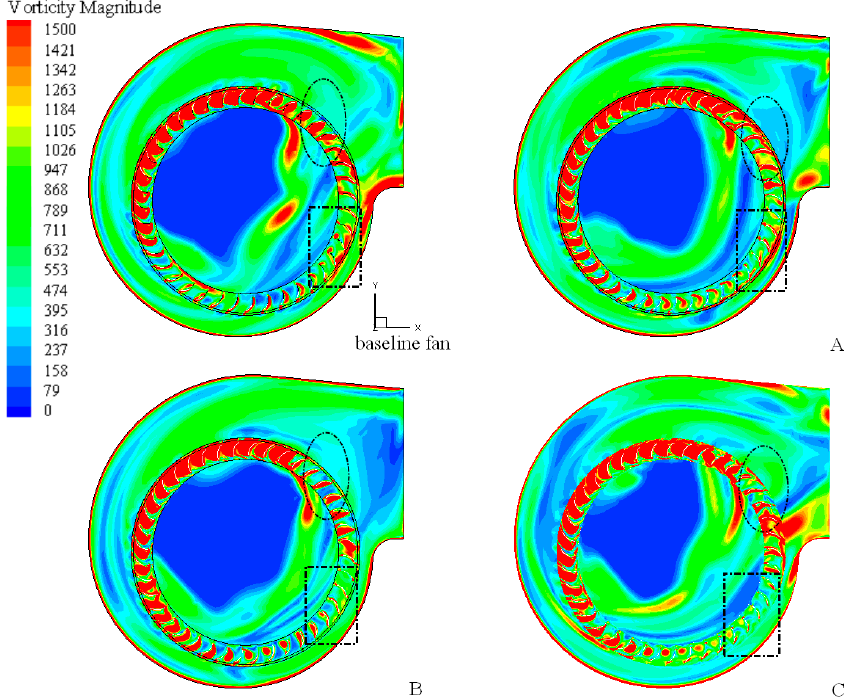
Figure 18. Contour of vorticity magnitude for the z = 75 mm plane at a rated flow rate Q / Q n = 1.000. ( A ) model-A; ( B ) model-B; ( C )